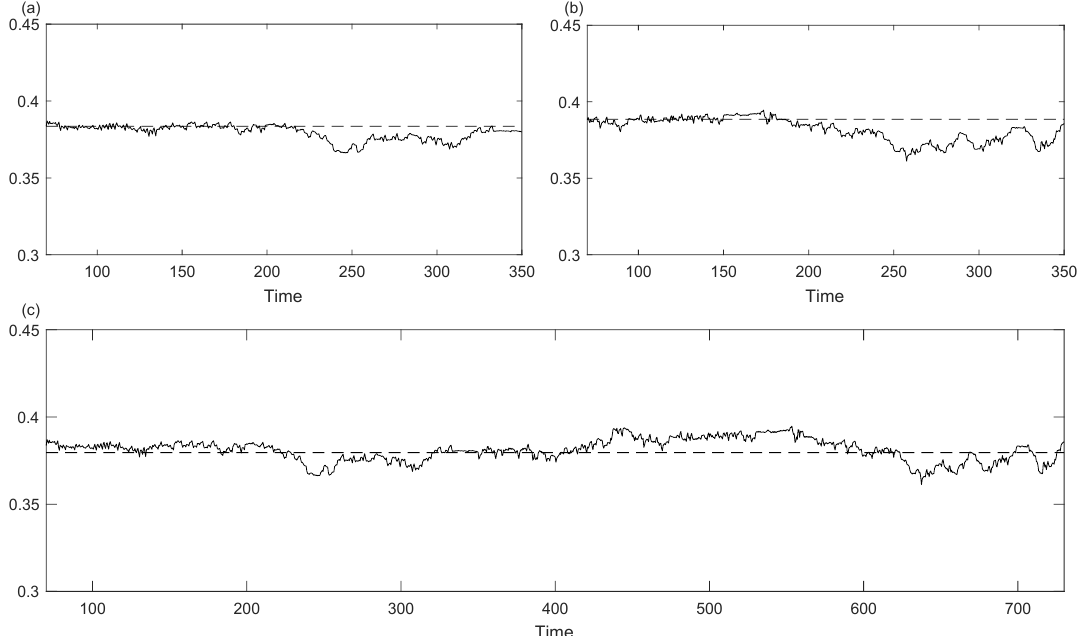
Figure 9. Sample entropies of series 1, 2 and 3 (see ( a ), ( b ) and ( c ) respectively) considering subseries centered at different times with time radius τ = 50. The corresponding global SampEn is represented with a dashed